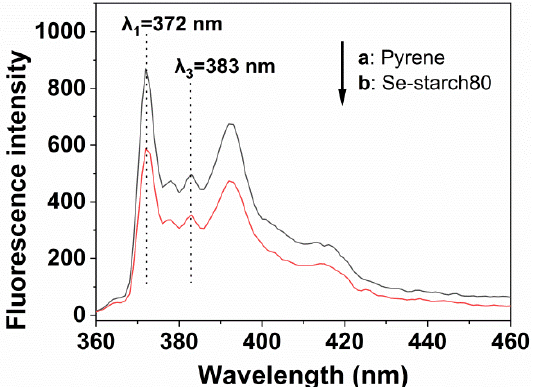
Figure 5. Fluorescence spectra of pyrene solution and the pyrene/Se-starch80 solution, where the concentration of pyrene was 1.0 × 10 − 6 M.